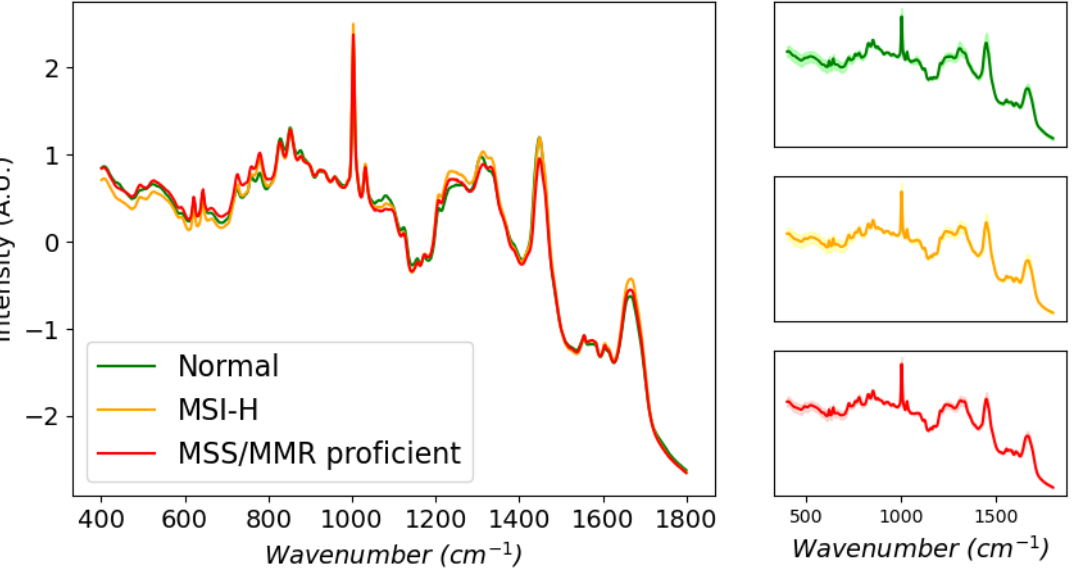
Figure 2. Average normalised spectrum by class. Right panels, average spectra with shaded areas indicating 1 standard deviation.